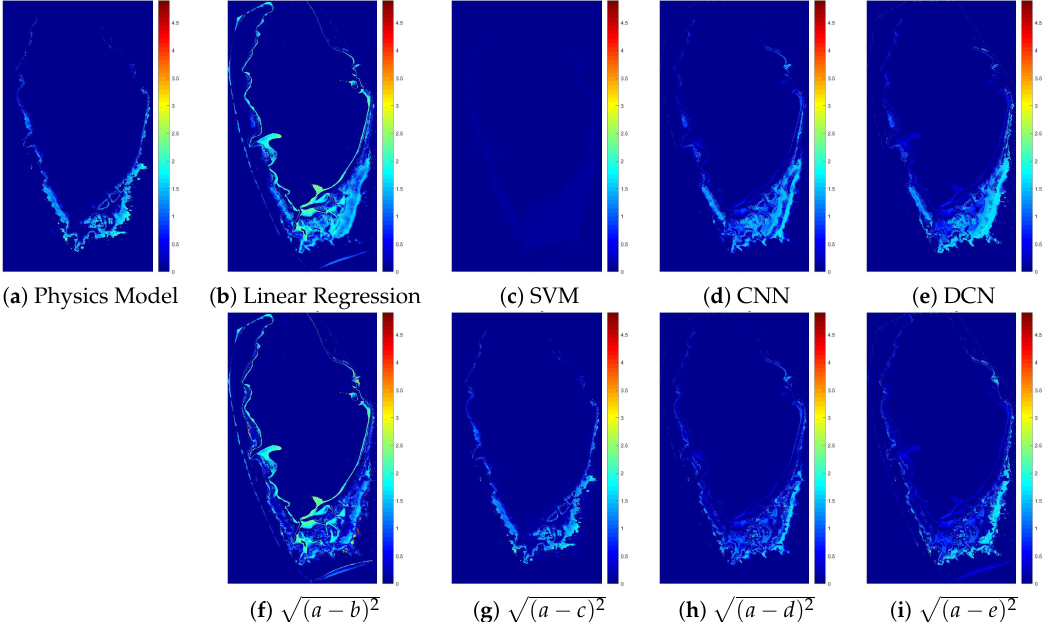
Figure 5. LAI mapping at Saint Joseph Bay produced by models trained with patches from the selected regions. The LAI maps are masked to show only those pixels that are classified as seagrass by the capsule network.